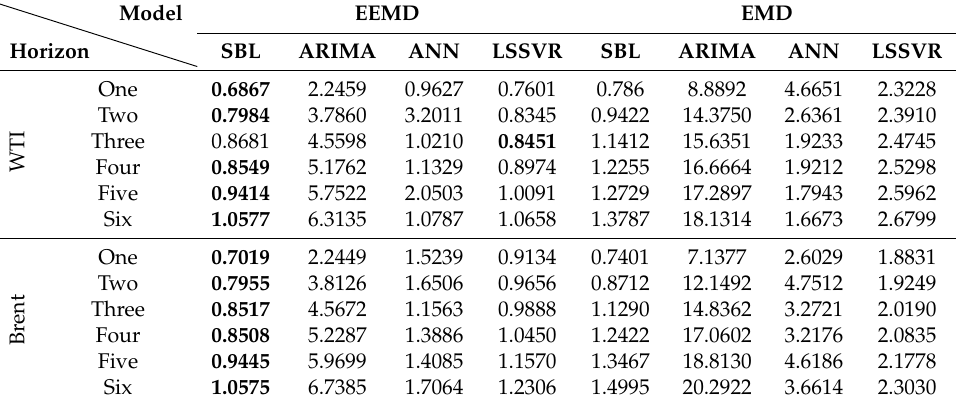
Table 8. The RMSE values by different ensemble models on WTI and Brent crude oil prices.